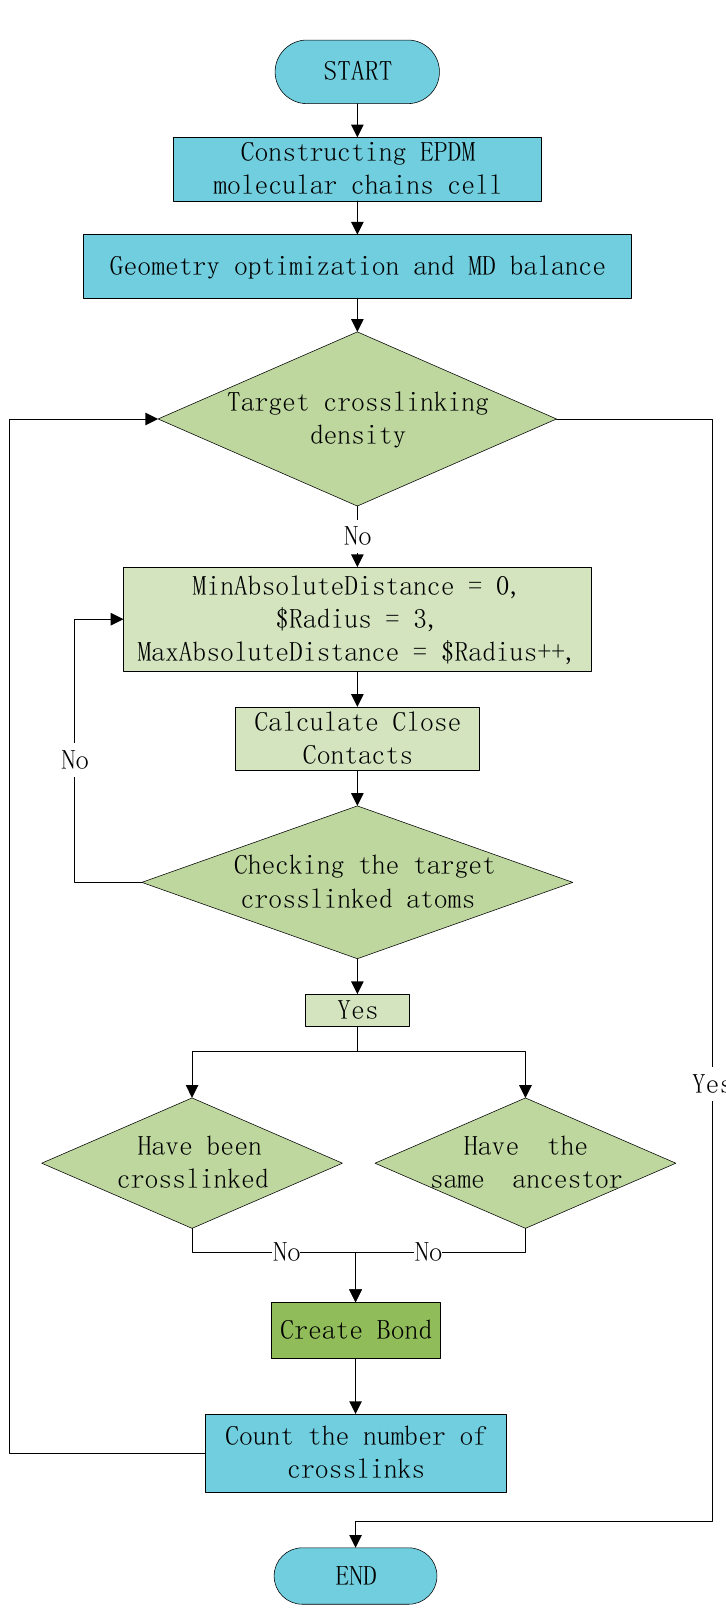
Figure 3. The cross-linking loop algorithm.